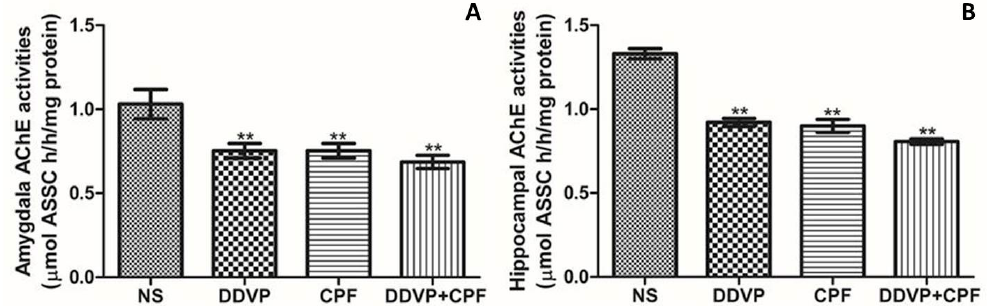
Figure 4. The effects of oral exposures to normal saline (NS), dichlorvos (DDVP), or/and chlorpyrifos (CPF) on: ( A ) amydaloid acetylcholinesterase (AChE) activities; and ( B ) hippocampal AChE activities in the exposed rats. Double asterisks (**) indicate a significant ( p ≤ 0.05) decrease when compared with the NS rats. One-way analysis of variance (ANOVA) with a post hoc Bonferroni’s multiple comparison test.